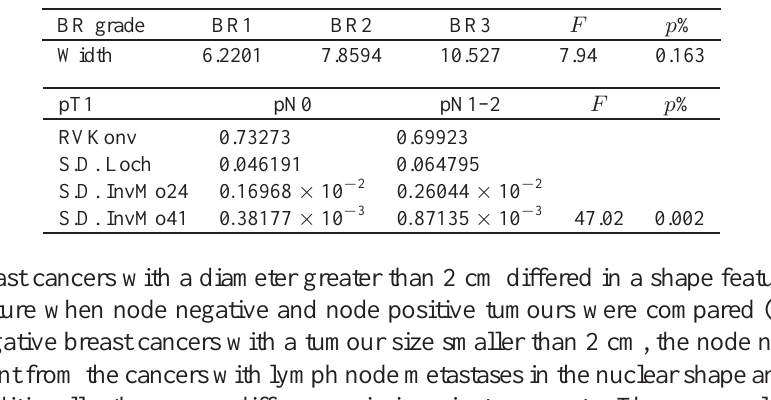
Table 8 p53 negative cases. Comparison of different clinicopathological